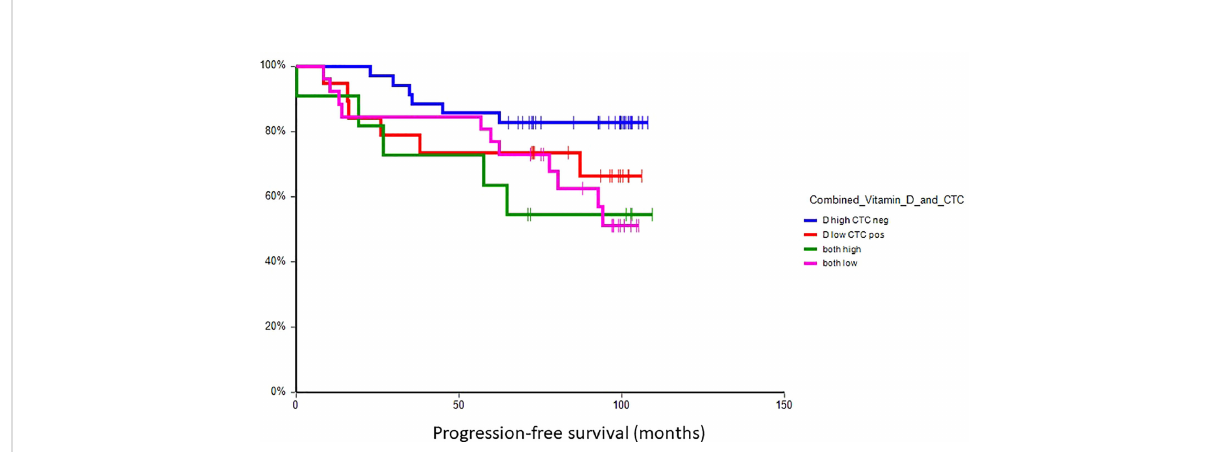
FIGURE 4 Kaplan – Meier estimates of probabilities of disease-free survival according to plasma vitamin D level and CTC status in primary breast cancer patients (N = 91). Patients with plasma vitamin D levels above median and undetectable CTC had signi fi cantly better DFS as compared to